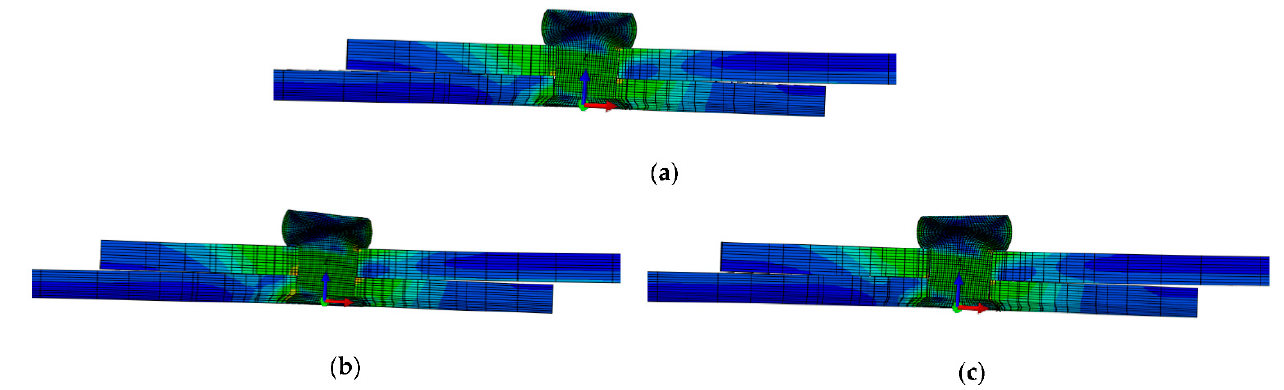
Figure 13. Simulation results of riveted piece after transverse stretching: ( a ) the reference deformation and stress result of the punch at 0° when the punch is not deflected (0-0); ( b ) the deformation and stress result of the punch pressing down at an angle of 3° in the direction of 0° (0-3); ( c ) the deformation and stress result of the punch pressing down at an angle of 3° in the direction of 180° (180-3).